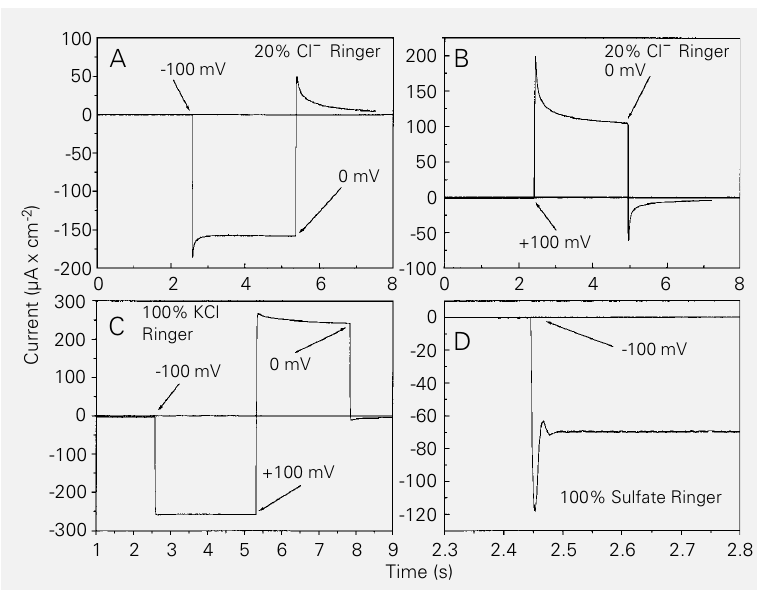
(s)Figure 2 - Response of the skin to voltage steps. A , Current re- sponse to voltage steps in the subsecond and few second time range in symmetrical KCl Ringer with [Cl - ] = 23.4 mM with the voltage sequence 0 fi -100 mV fi 0 mV. B , Same solution as in A and voltage program 0 mV fi +100 mV fi 0 mV. C , Current responses to voltage pulses